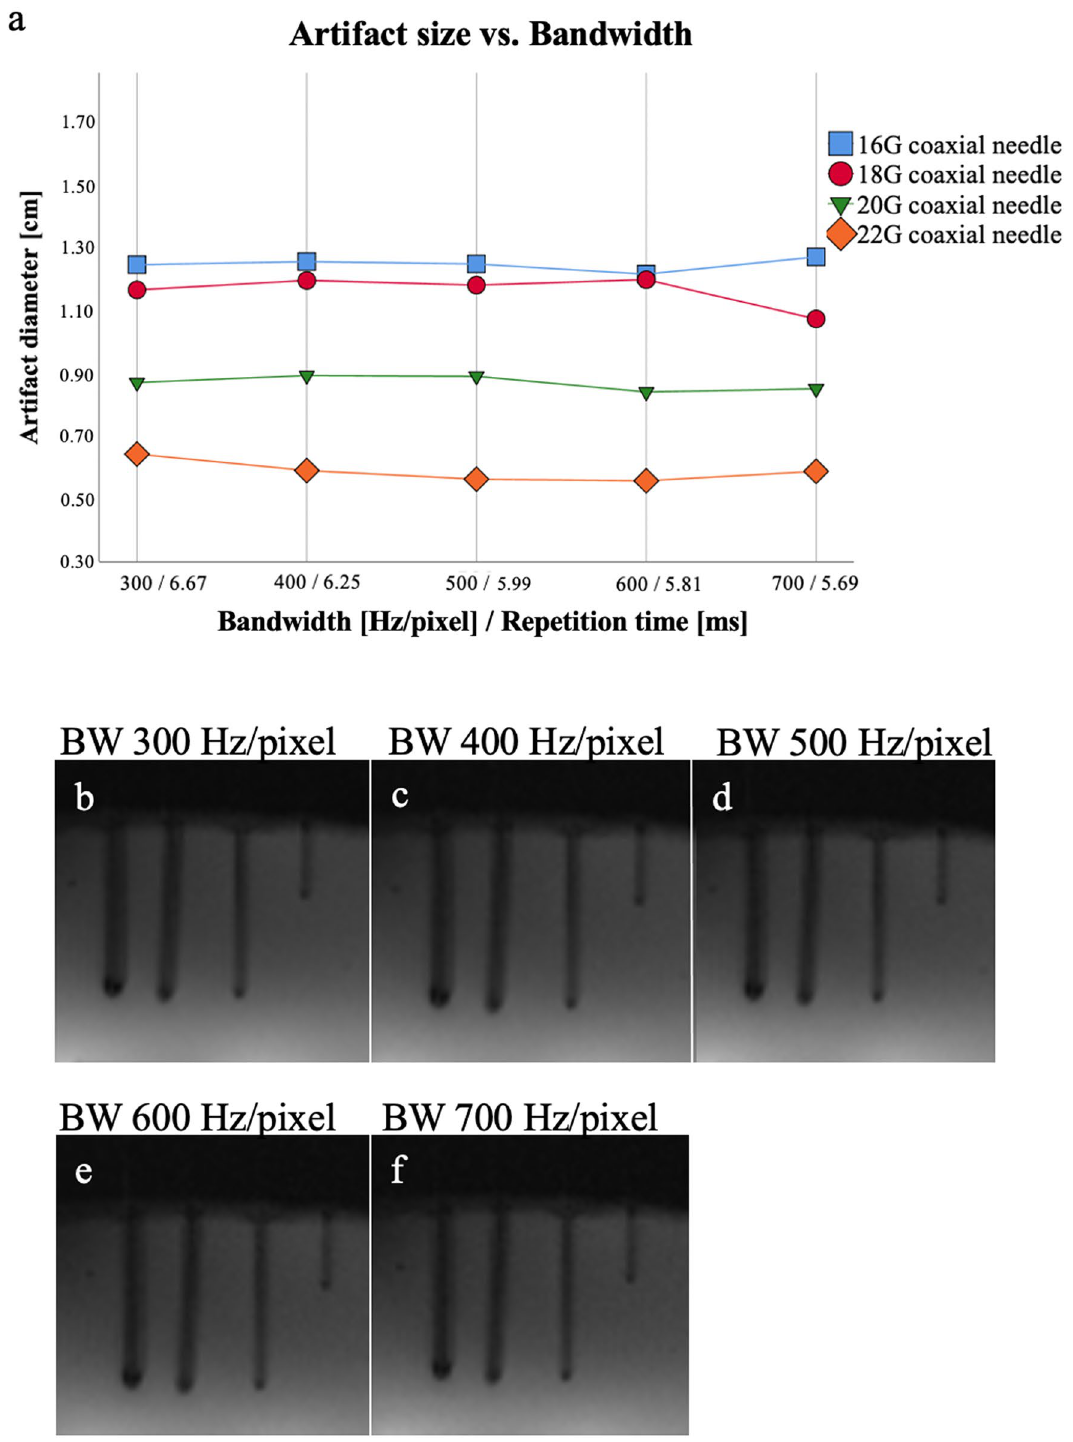
Figure 2. Scan series 2. Mean values (of both readers) of the measured artifact diameters ( a ) of the 16G, 18G, 20G, 22G needles with different BWs of the T1-weighted GRE sequence. There was no significant correlation of artifact diameter with BW for 16G ( r = 0.300), 18G ( r = − 0.100), 20G ( r = − 0.600), and 22G ( r = − 0.700) MR-compatible needle, in ( b – f ) the visual correlate is shown. BW = bandwidth, Hz = Hertz, G =